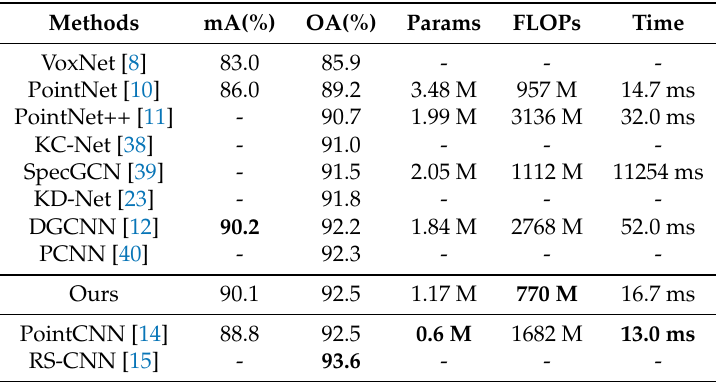
Table 1. Classification results on the ModelNet40